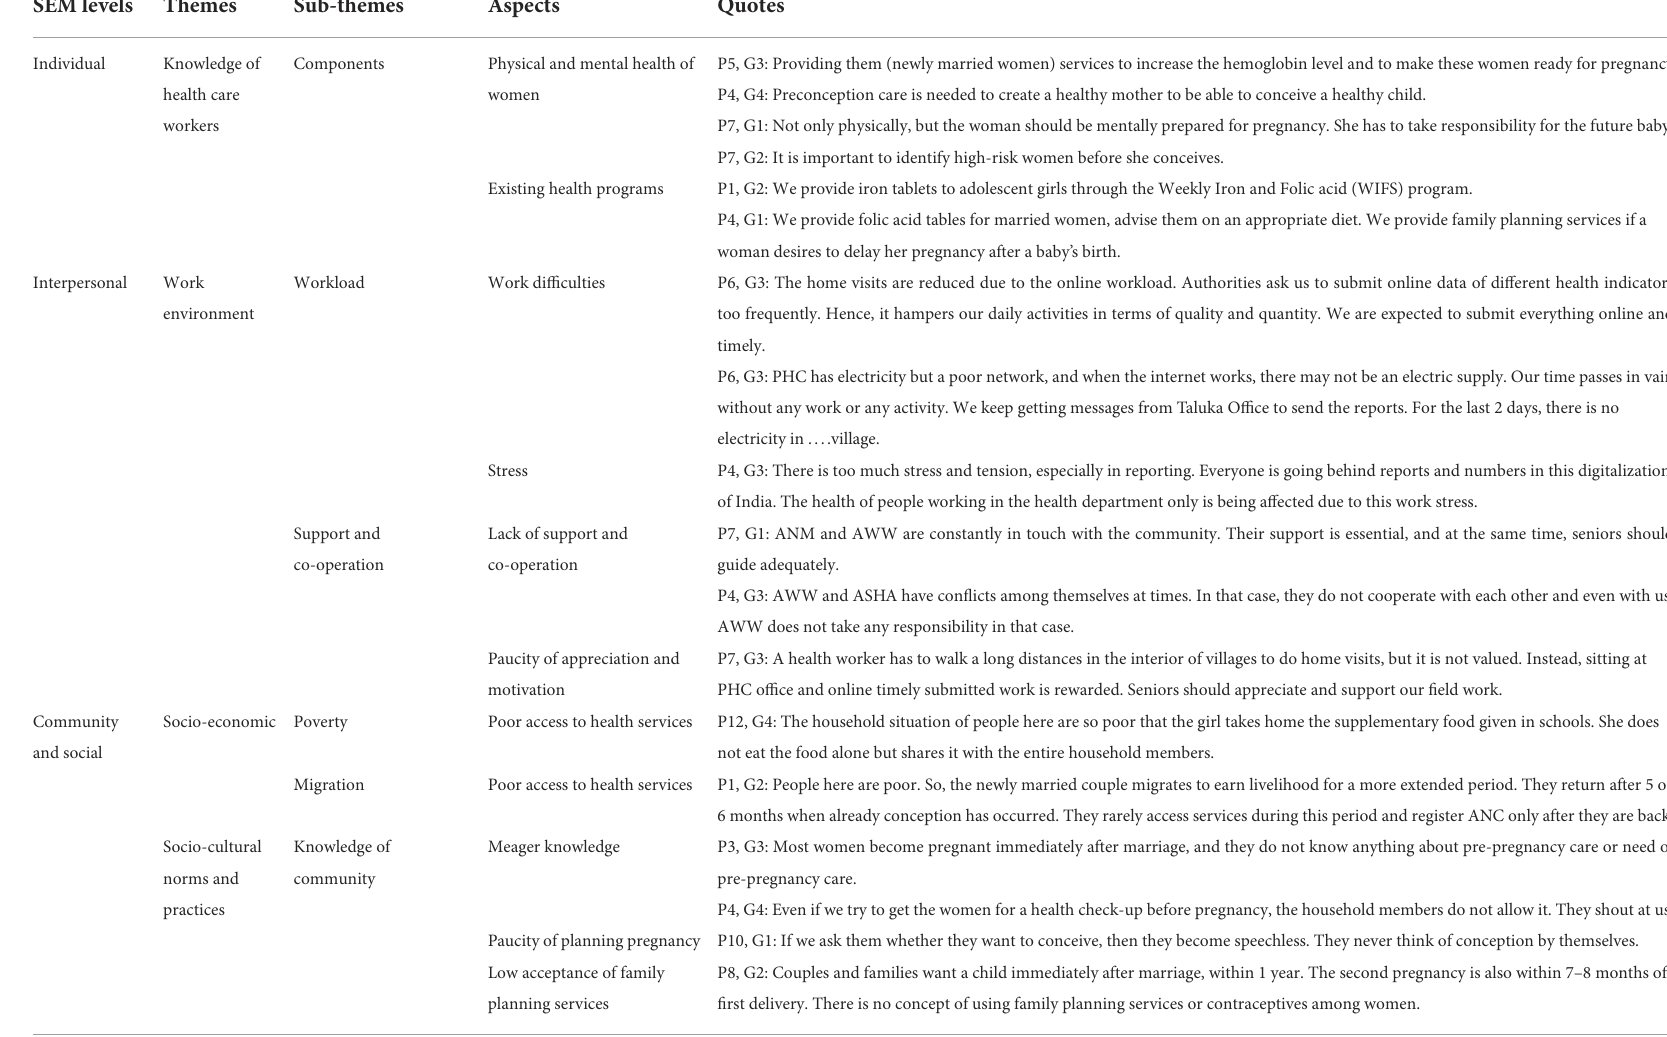
TABLE 3 Identified themes and sub-theme based on Socio-Ecological Model after focus group discussion. SEM